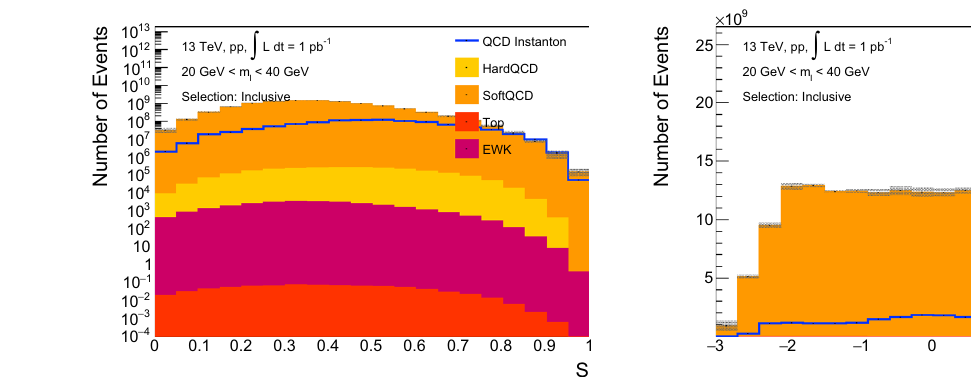
spherical events compared to the background